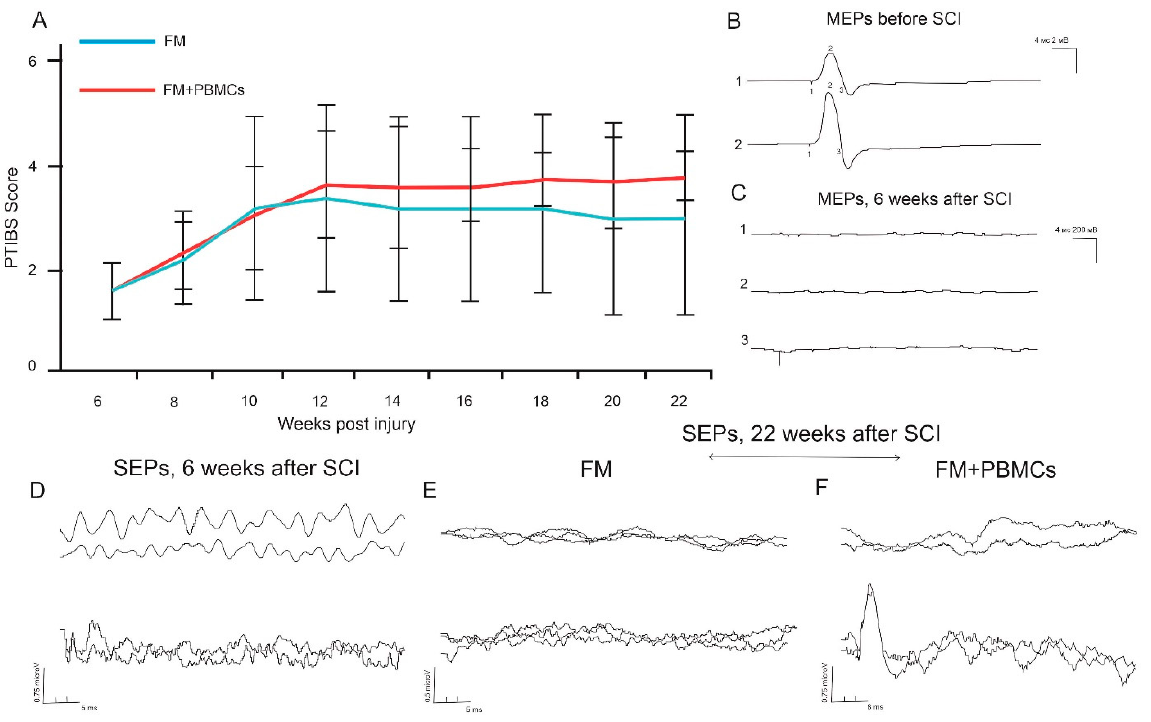
Figure 5. Behavioral testing and electrophysiology results in pigs. Locomotor Porcine Thoracic Injury Behavioral Scale (PTIBS) scores of FM alone ( n = 5, blue line) and FM+PBMC ( n = 5, red line) groups ( A ). No significant differences were found between the study groups throughout the study. Electrophysiology results show motor evoked potentials (MEPs) before the SCI ( B ) and MEPs/somatosensory evoked potentials (SEPs) 6 weeks after the SCI ( C , D ). After 22 weeks, no cortical or lumbar SEPs were recorded in 4 pigs of the group treated alone after FM ( E ). Both lumbar and cortical peaks ( F ) were recorded in 2 animals of the group treated with FM+PBMCs.